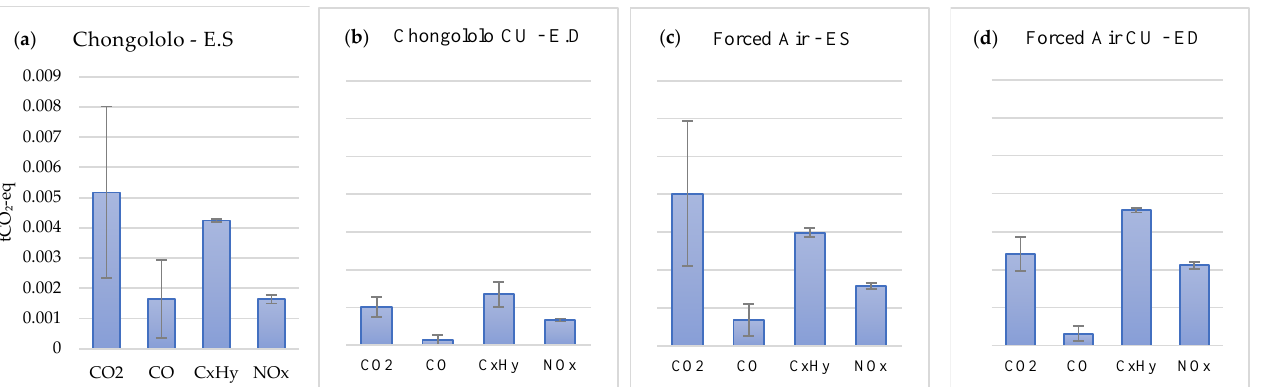
Figure 5. Emission factors for conventional curing units, considering the biomass firewood ( a-c ) of E. saligna (ES), firewood of E. dunnii (ED), and Pellets. 3.6. Scenarios 3.6.1. Efficiency in Forest Biomass Consumption In relation to the base scenario of conventional PAs using E. saligna firewood, there was a reduction in firewood consumption of 41.21% when compared to the use of Chon- gololo PA and E. dunnii firewood type biomass. The reduction was even greater if pellets are used, even in adapted conventional PAs, with a reduction of 60.28% in the amount of biomass consumed, as shown in Table 3. Table 3. Quantification of biomass consumption considering the different scenarios of curing units and biomass. Biomass Curing Unit